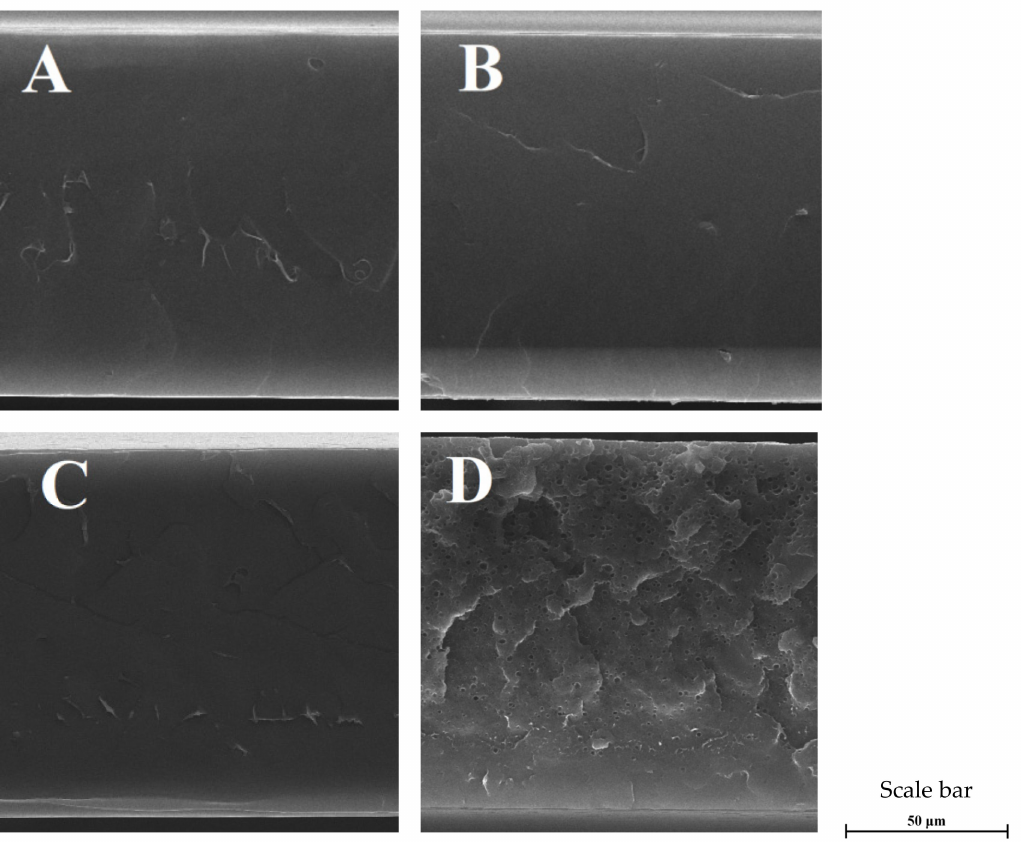
Figure 2. Cross-sections of films PLA modified with ( A ) 5%, ( B ) 10%, ( C ) 20% and ( D ) 50%